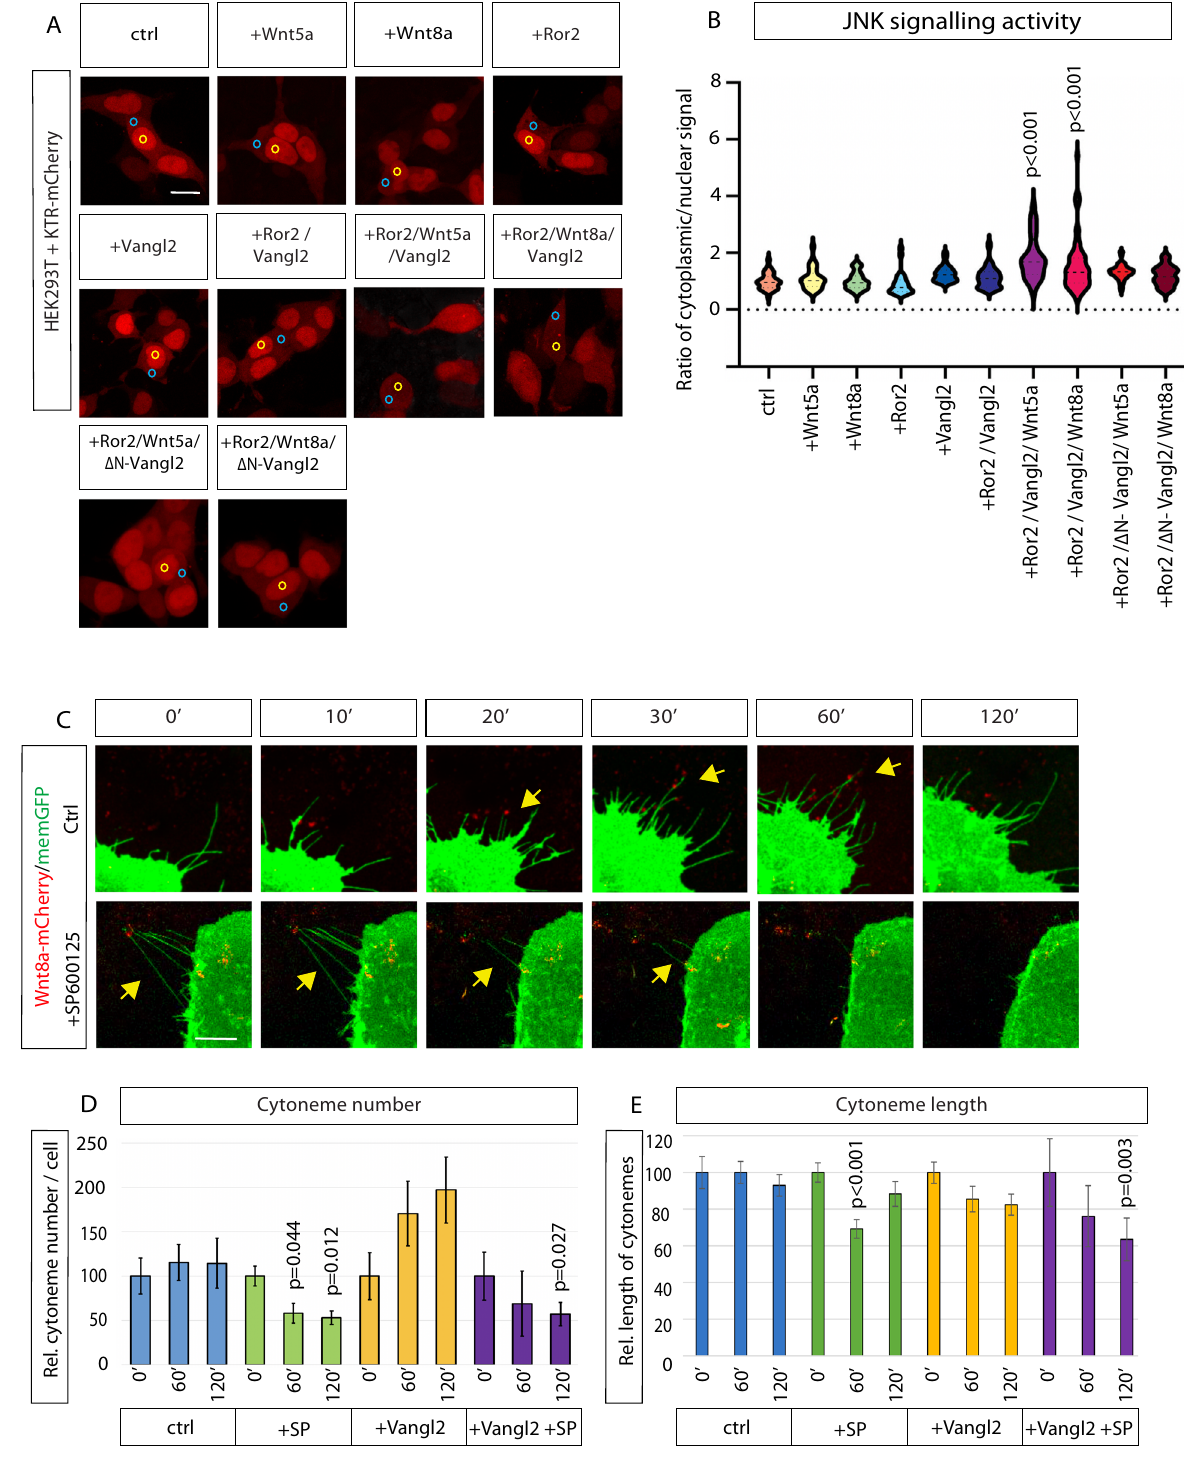
number after 1 h. Vangl2-expressing cells, which had longer protrusions (as in Fig. 2L) prior to the addition of SP600125, also had a signi fi cant change in the number and length of cytonemes compared to untreated Vangl2-expressing fi bro- blasts. A detailed analysis of cytoneme lengths showed a speci fi c loss of extremely long signaling fi lopodia as a result of JNK inhibition (Supplementary Fig. 6B). We also tested the involvement of RhoA/ROCK signaling as it can be similarly activated downstream of PCP signaling to regulate cytoskeletal